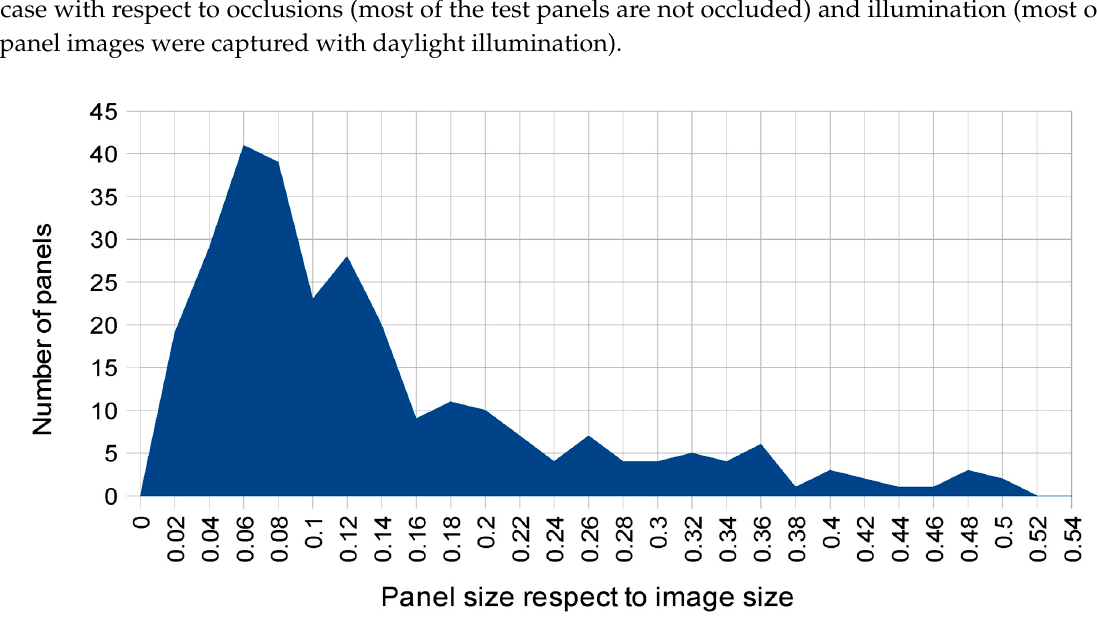
Figure 5. Histogram of panel coverage sizes in test